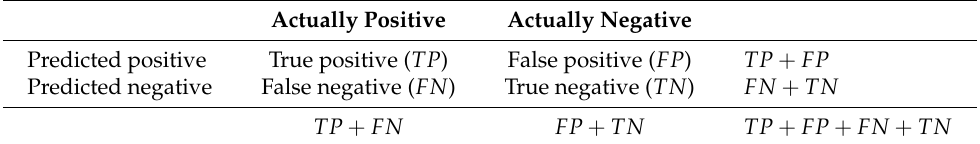
Table 7. Schematic overview of a binary confusion